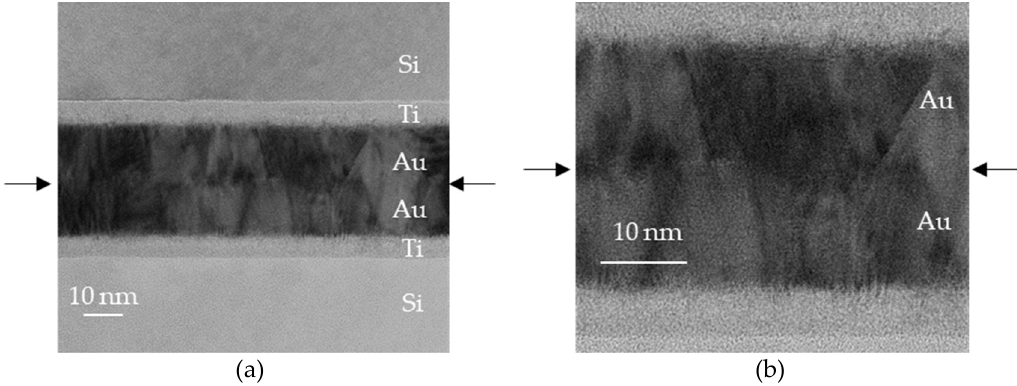
Figure 9. Transmission electron microscope (TEM) images of Au–Au bonding interface after 30 s Ar plasma treatment. Arrows indicate original interface: ( a ) low magnification; ( b ) high magnification.